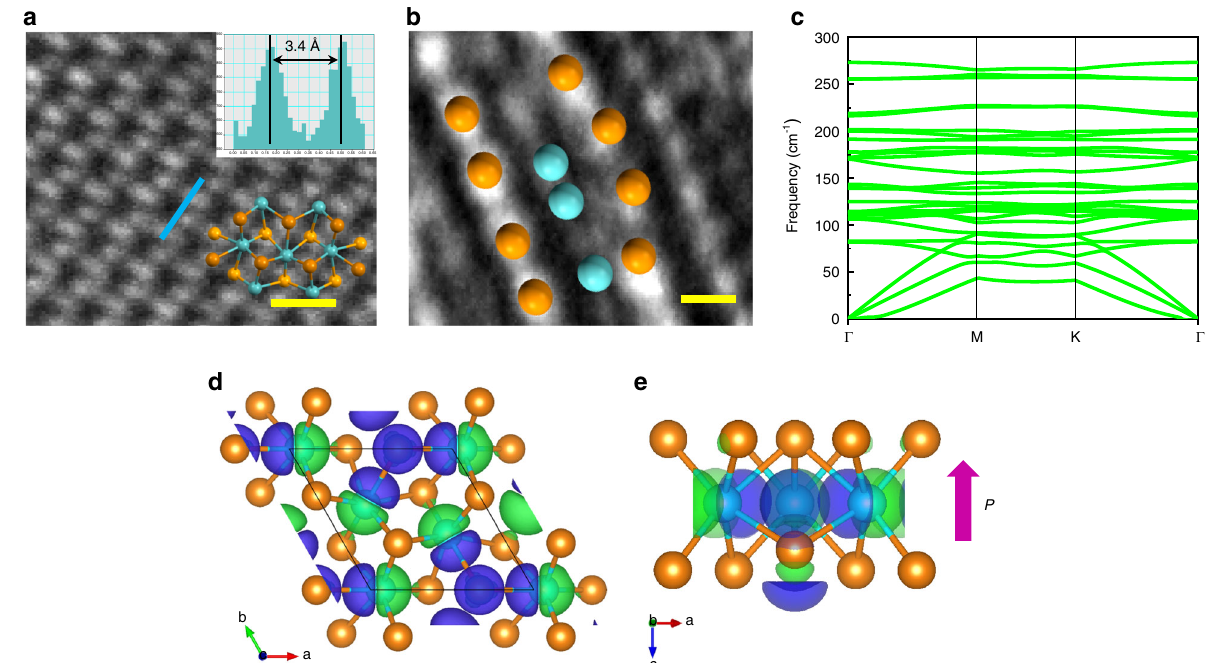
Fig. 3 Atomic structure and theoretical calculations on ferroelectricity in d 1T-MoTe 2 . a Top-view HRTEM image and intensity pro fi le, the atomic structure of d 1T-MoTe 2 is placed on top, scale-bar, 0.5 nm. b Atomic structure image of monolayer d 1T-MoTe 2 and the inset shows atomic structure model (cyan and orange colors represent Mo and Te atoms, respectively), scale-bar, 2 Å. c Phonon dispersion of d 1T-MoTe 2 . d , e Top-view and side-view of charge density difference between ferroelectric d 1T and paraelectric 1T phases (green, purple, cyan, orange, and pink colors denote negative charge, positive charge, Mo atom, Te atom, and polarization,